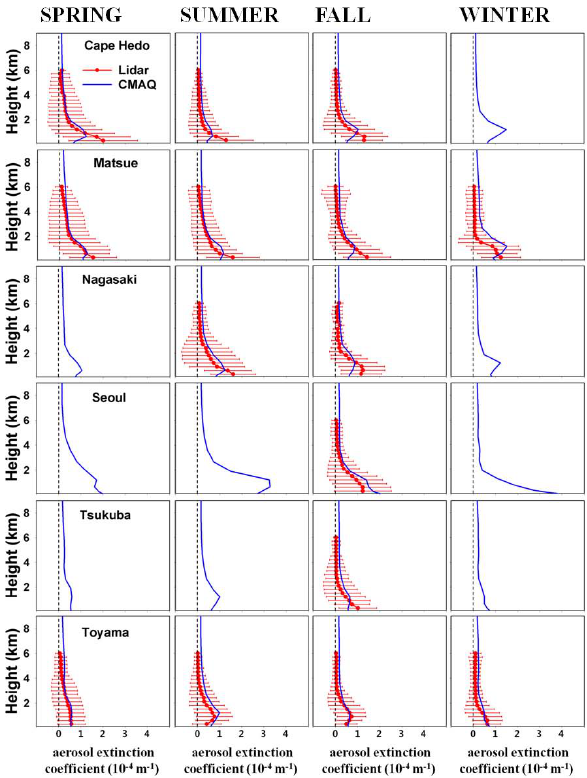
Fig. 7. Vertical profiles of the CMAQ-simulated and LIDAR- derived aerosol extinction coefficients ( σ ext , 10 − 4 m − 1 ) from six ADNET sites in East Asia for 2006. Blue lines and red circles rep- resent σ ext obtained from the CMAQ modeling and the LIDAR net- work, respectively. The horizontal red bars indicate ± σ (standard deviation) of the LIDAR-derived aerosol extinction coefficients. The blue dashed lines indicate the zero values of aerosol extinction